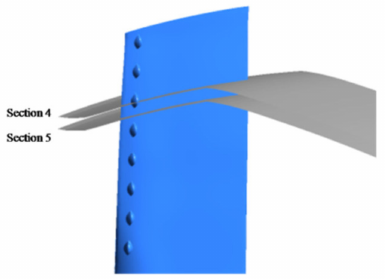
Figure 13. Schematic diagram of spanwise